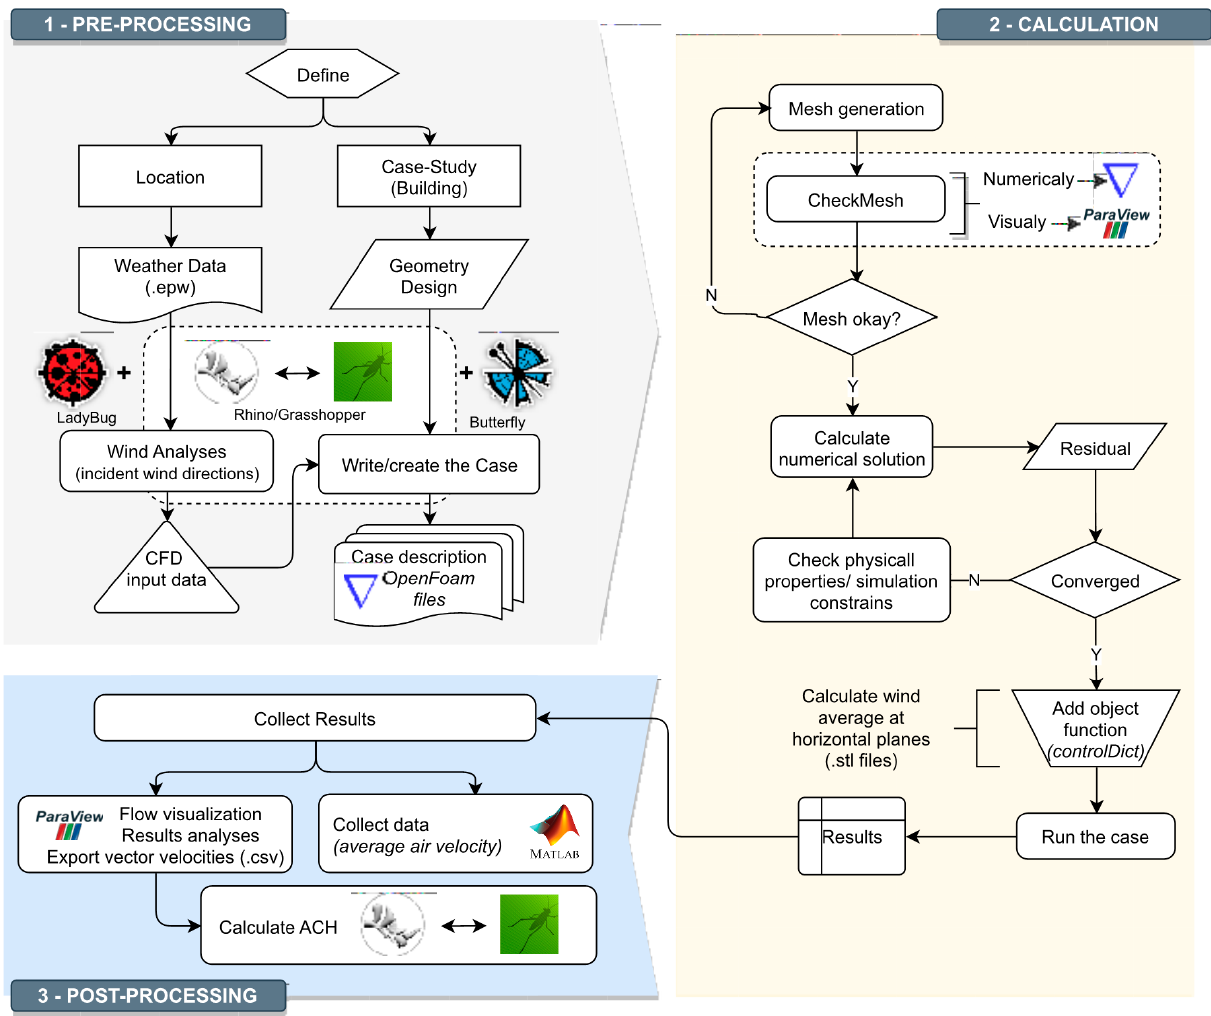
Figure 1. Steps to assess wind-driven natural ventilation through computational fluid dynamics (CF)D within parametric 3D modeling.